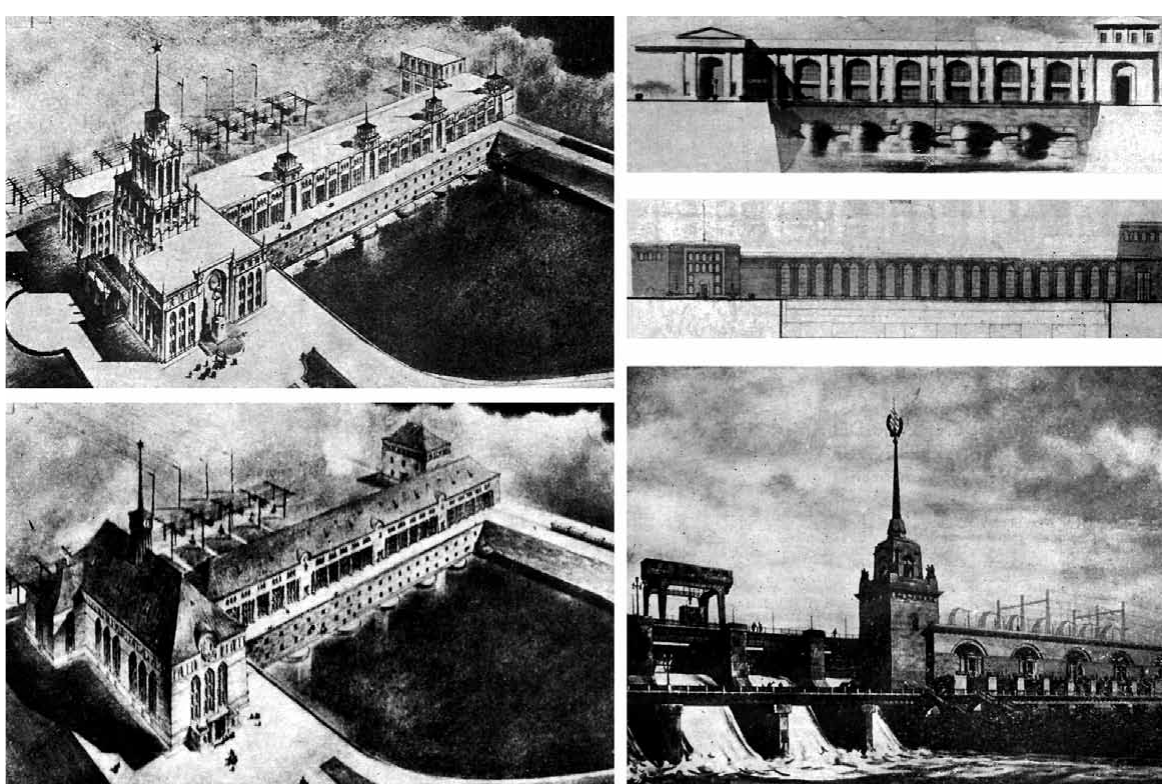
fig. 3. left – two versions of the 2 nd prize entry. Top right – 1 st mention and 3 rd prize recipients. Bottom right – Tymliansk hydroelectric plant – project illustration. Source: Arhitectura, 1952, 1–2: